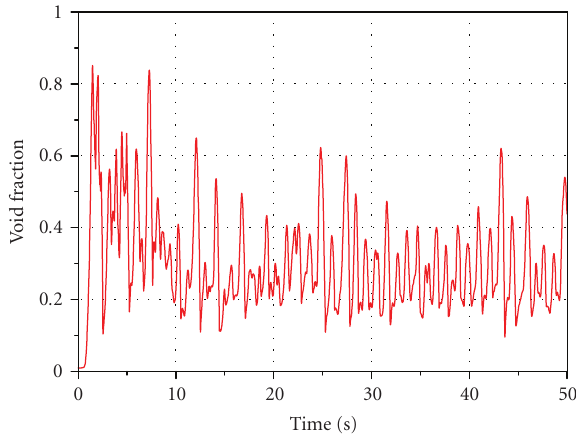
Figure 4: Calculated void fraction in the upper part of the central downcomer (among points 1 and 2).